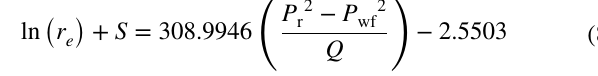
Table 16 Well operating points for different simulated cases Simulated